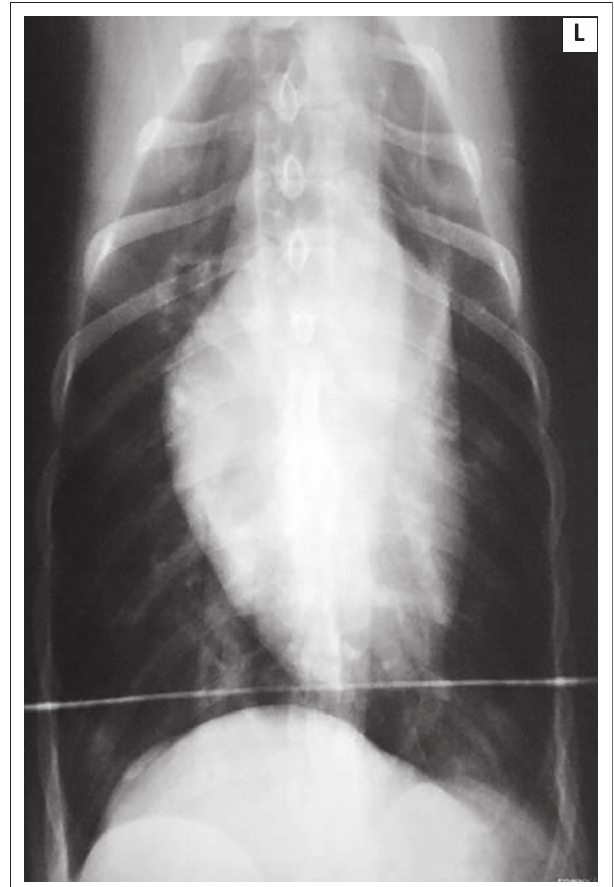
Source : Radiograph taken by Marlies Böhm; photo of radiograph taken by Sandra Basson FIGURE 2: Ventrodorsal thoracic radiograph. The radiodense horizontal line caudal to the heart is the edge of the cradle the dog was lying in to assist positioning. Note subtle diffuse increase in radiodensity at the edges of the caudal lung